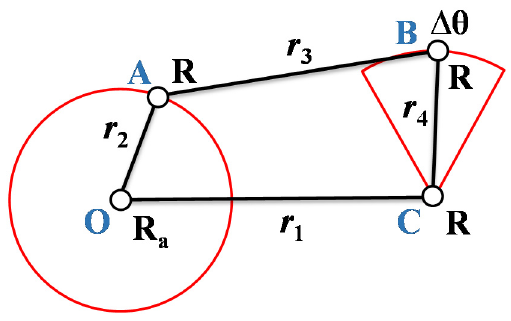
Figure 5. Geometric analysis of four-bar linkage [10].